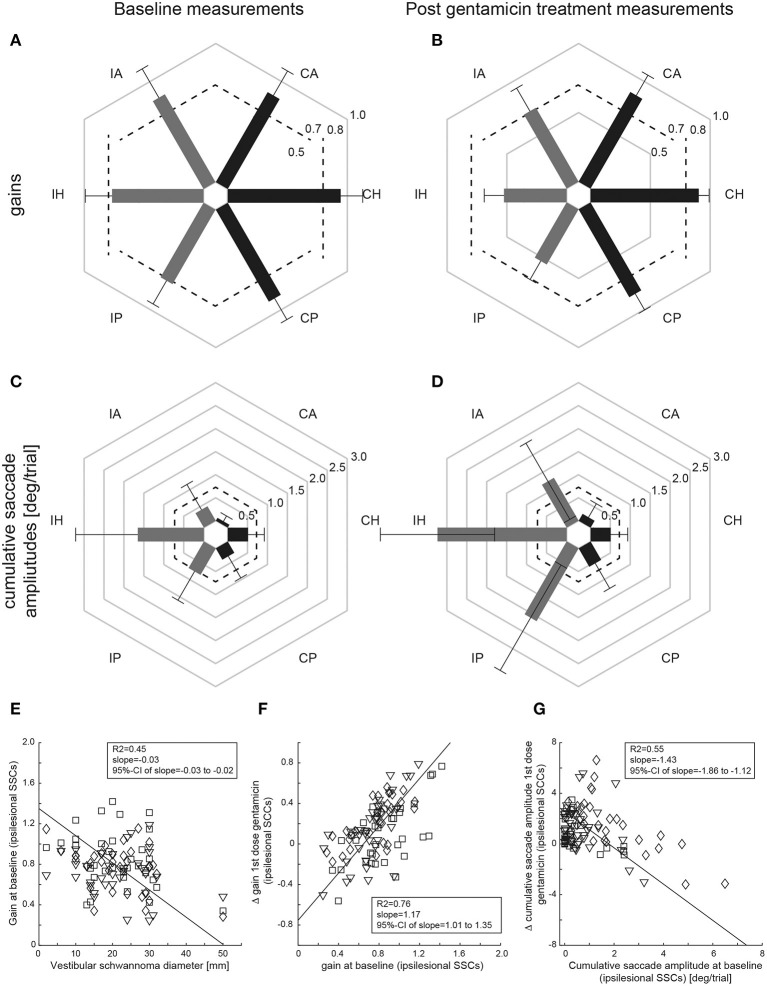
Mean (±1SD) gains (A,C) and CSA (B,D) of all patients (n = 34) are shown separately for baseline (left column) and after gentamicin treatment (right column), with values from the affected [ipsilesional (I)] side and the unaffected [contralesional (C)] side indicated by gray and dark bars, respectively. Gain values (from 0 to 1) and CSA (°/trial, from 0 to 3) are provided along the different hexagons. Cutoff values for reduced gains (<0.8 for the horizontal canals, <0.7 for the vertical canals) and for abnormally increased cumulative saccade amplitudes (>0.73°/trial) are indicated by dashed lines. In (E–G), correlation analyses using principal component analysis (PCA) are shown both for the size of the VS and for the aVOR gain of the individual SSCs on the affected side at baseline (E), the difference (Δ) in aVOR gain (gain after 1st dose of gentamicin subtracted from gain at baseline) vs. baseline gain (F) and for the difference (Δ) in CSA (CSA at baseline subtracted from CSA after 1st dose of gentamicin) vs. baseline cumulative saccade amplitude (G). The diamonds (horizontal canals), squares (anterior canals), and inverted triangles (posterior canals) refer to single-subject and single SCC measurements; the solid black line represents the fit of the PCA, with details shown in the inlets [including the 95% confidence interval (CI) of the slope]. Note that individual results from the three ipsilesional SCCs are combined for the PCS.